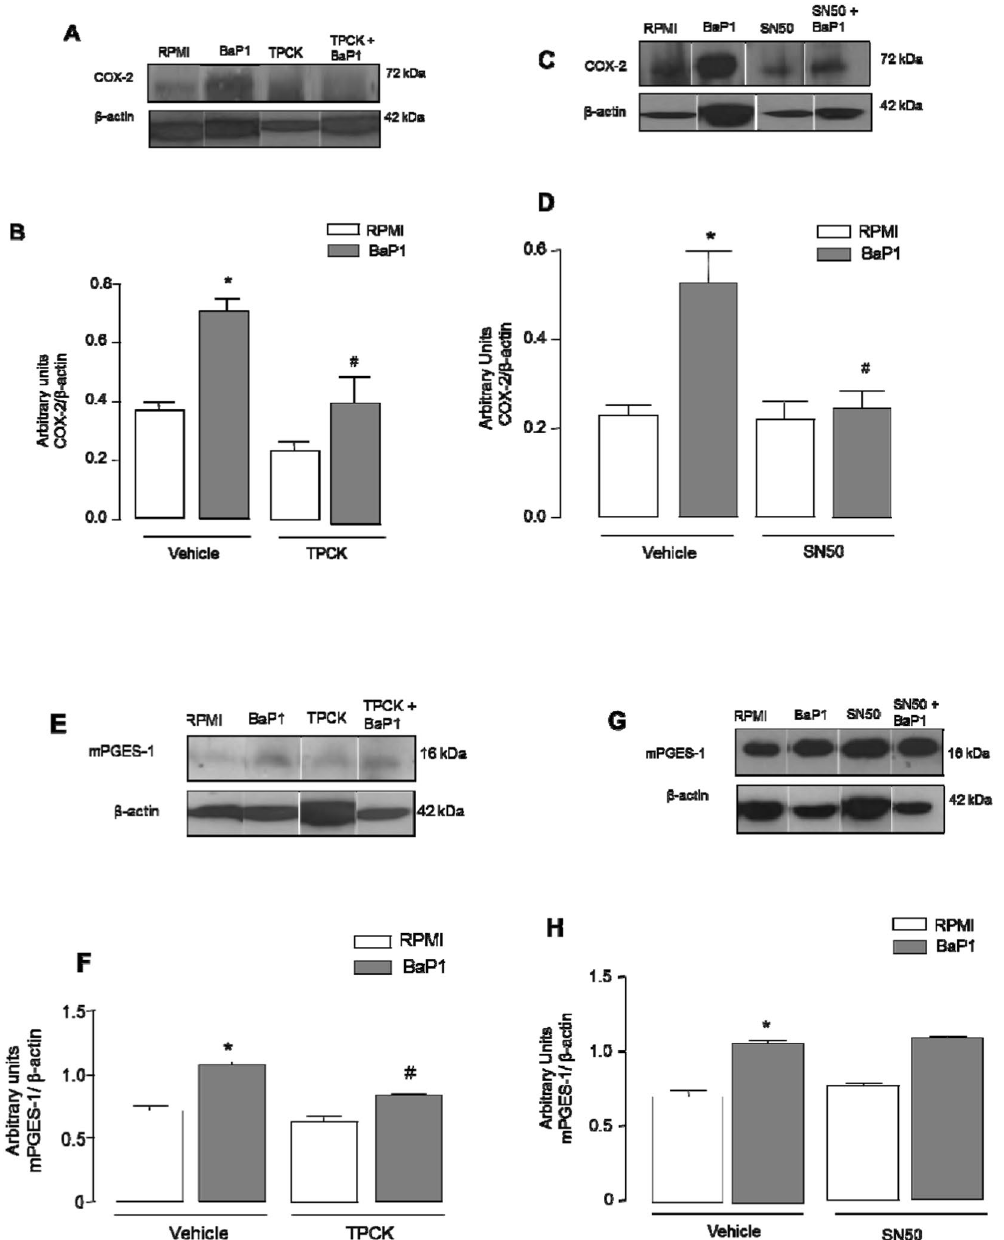
Figure 5. NF-kB transcription factor is relevant to BaP1-induced COX-2 and mPGES-1 protein expression by FLSs. Isolated FLSs were pretreated with TPCK (25 μ M) or SN50 (50 μ g/mL) for 1 hour and stimulated by BaP1 (12.5 mg/mL) or RPMI (control) for 3 h. ( A , C ) Representative Western blotting of COX-2 and β -actin (loading control) showing immunoreactive bands. ( B , D ) Densitometric analysis of immunoreactive COX-2 bands. ( E , G ) Representative Western blotting of mPGES-1 and β -actin (loading control) showing immunoreactive bands. ( F and H ) Densitometric analysis of immunoreactive mPGES-1 bands. ( E ) Results are expressed as mean ± SEM of 3–4 samples. * p < 0.05 relative to control. # p < 0.05 relative to BaP1 (one-way ANOVA, Bonferroni post test). Blots were cropped from the full-length blots, which are demonstrated as Supplementary Figures 6(A–D) and 7(A–D) and cropped blots are indicated by